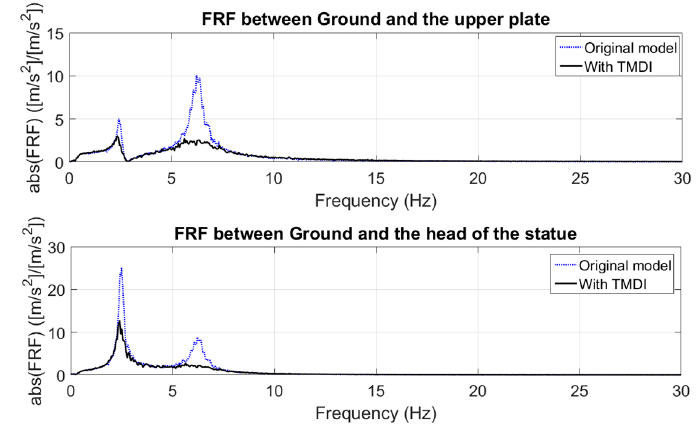
Figure 13. FRFs obtained from the MDOF model without and with TMDIs for case 2.